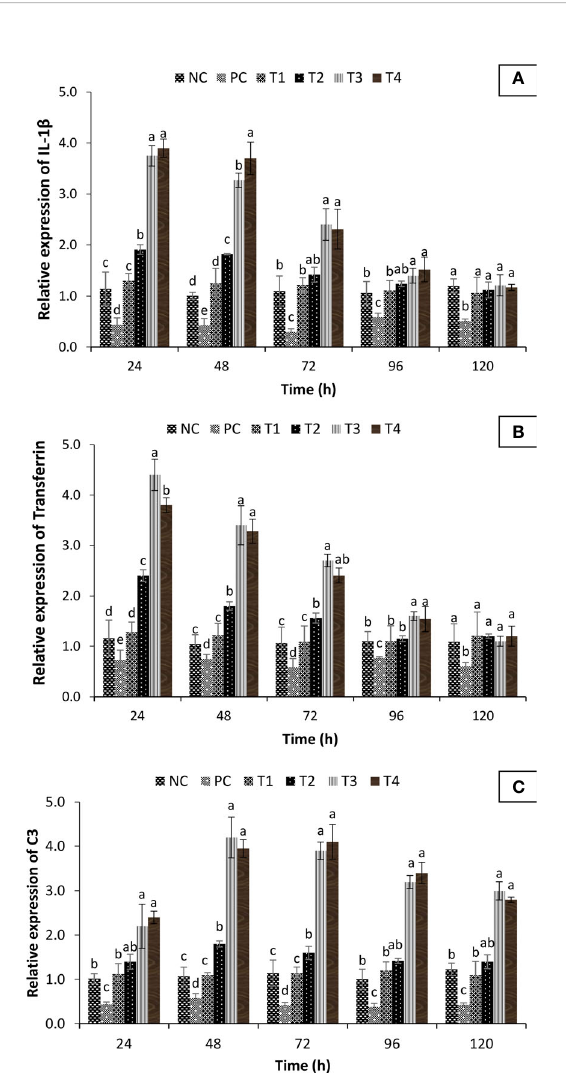
FIGURE 9 Fold change in immune gene expression of Pangasianodon hypophthalmus fi ngerlings against I. multi fi liis and A. hydrophila co- infection. (A) Expression of interleukin-1 b (IL-1 b ). (B) Transferrin and (C) C3 complement system as determined by quantitative real-time PCR. The expression level in the control group (- co-infection) was regarded as 1.0 and thereby the expression ratio of the positive control group (+ co-infection) and treatments (+ co-infection and turmeric oil) was expressed in relation to the control group. The results are the mean ± SE ( n = 3) and different letters indicate signi fi cant differences between treatment groups ( p < P. hypophthalmus fi ngerlings against I. multi fi liis and A. hydrophila co-infection.